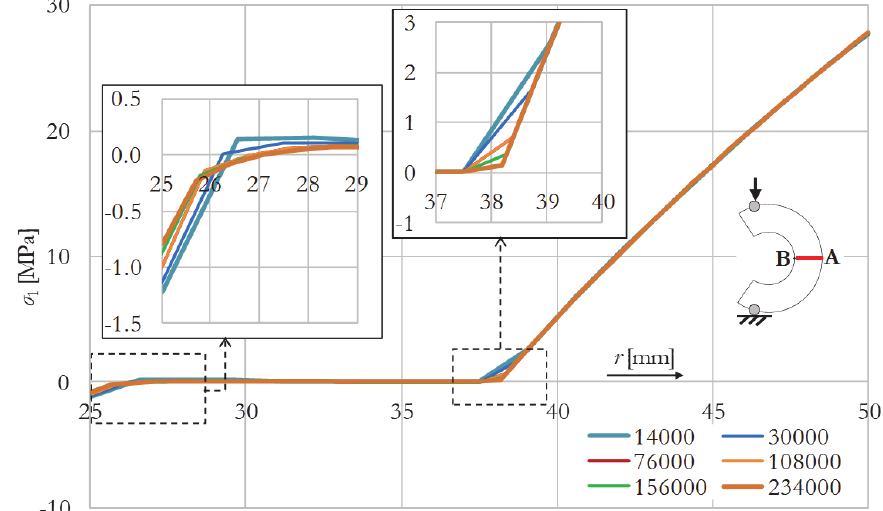
Figure 8: The dependence of the maximum principal stress σ 1 , developed along the AB locus, on the number of elements used for meshing the reference model.